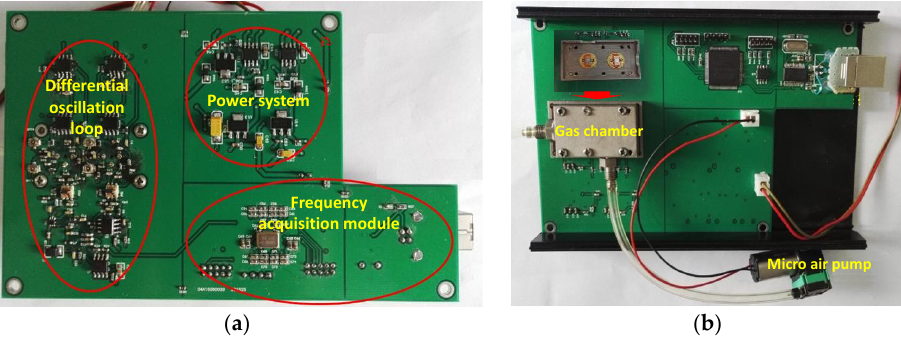
Figure 9. ( a ) The differential oscillation loop and ( b ) integrated sensor